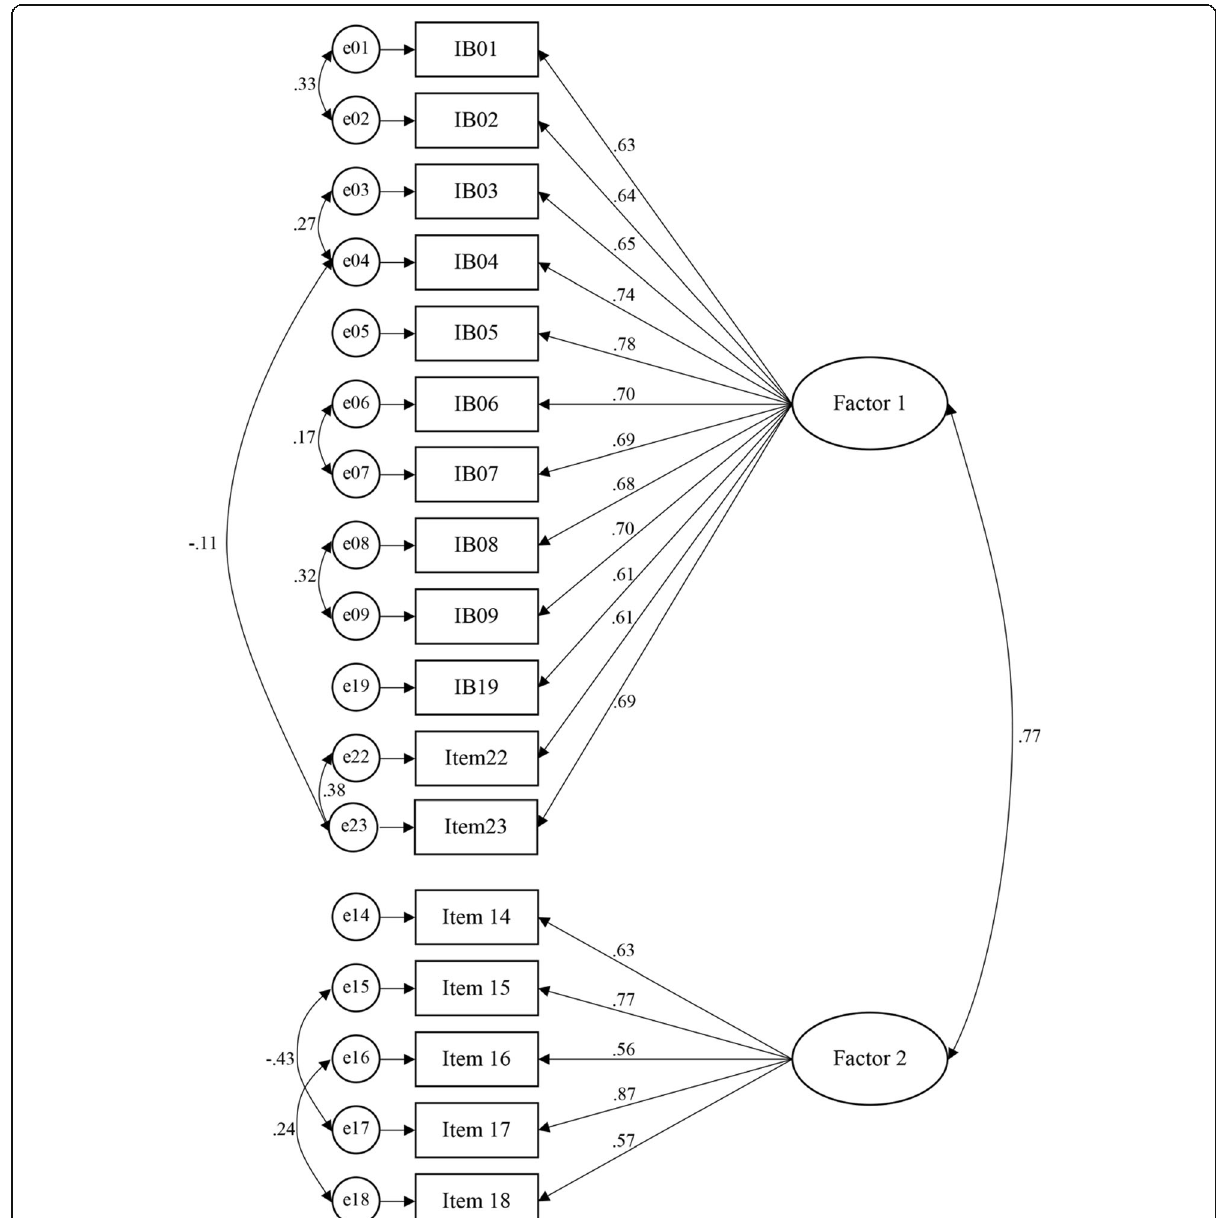
Fig. 1 Modified two-factor model of the standardized estimates path diagram. CFA model-fit: χ 2 (110) = 310.8, CFI = .95, RMSEA = 0.04, SRMR =